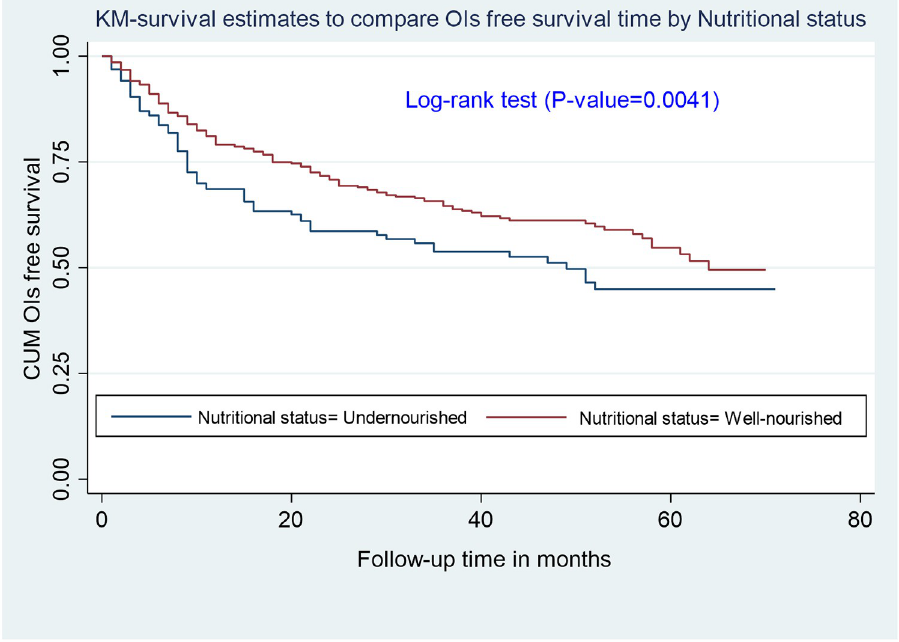
Fig 1. Kaplan-Meier survival curves to compare OIs free survival time between undernourished and well- nourished adults living with HIV on ART at Debre Markos Comprehensive Specialized Hospital, Northwest Ethiopia,